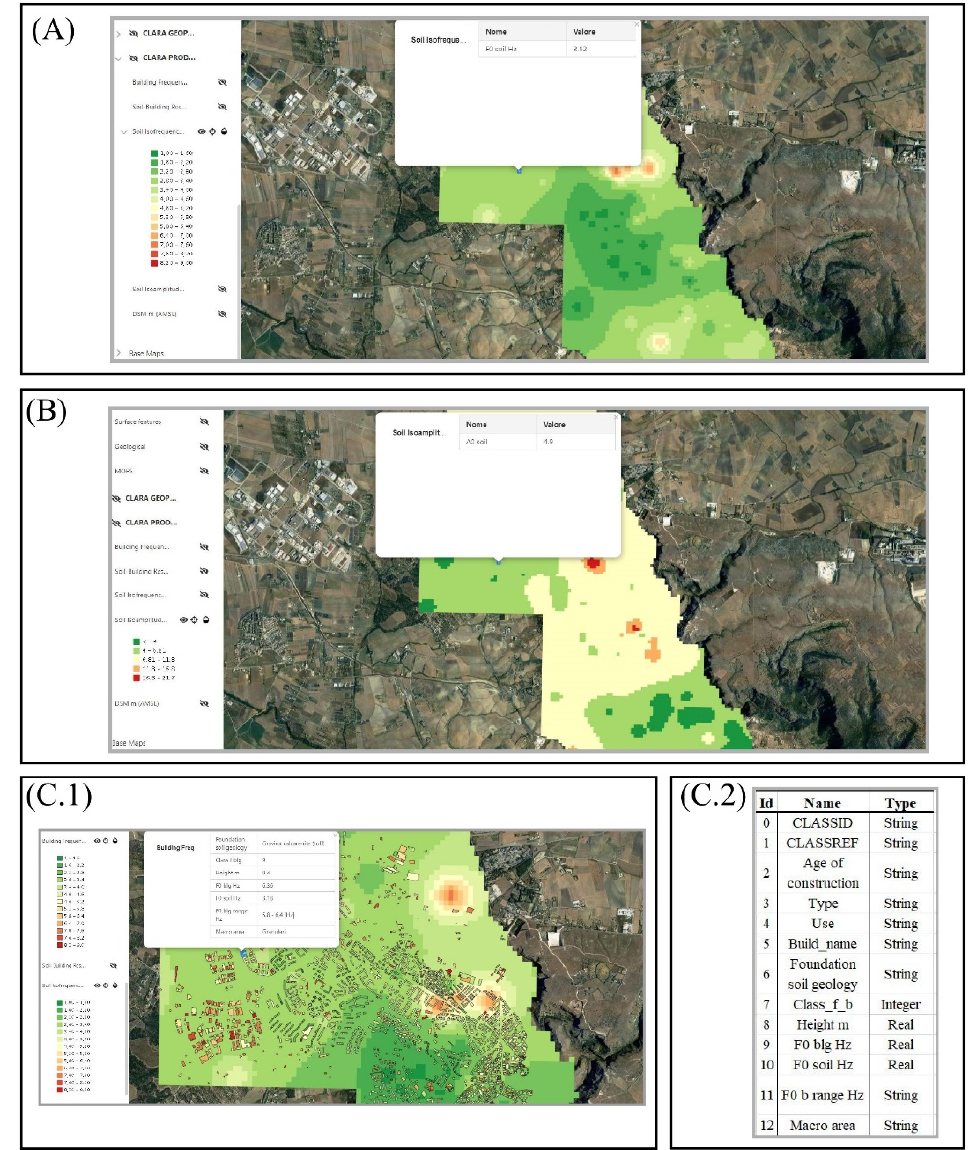
Figure 11. Screenshot of mapview and pop-up showing ( A ) soil isofrequency map; ( B ) soil isoam- plitude map; ( C.1 ) building frequency distribution overlying soil isofrequency map. The building frequency layer has an attribute table composed of thirteen fields ( C.2 ).